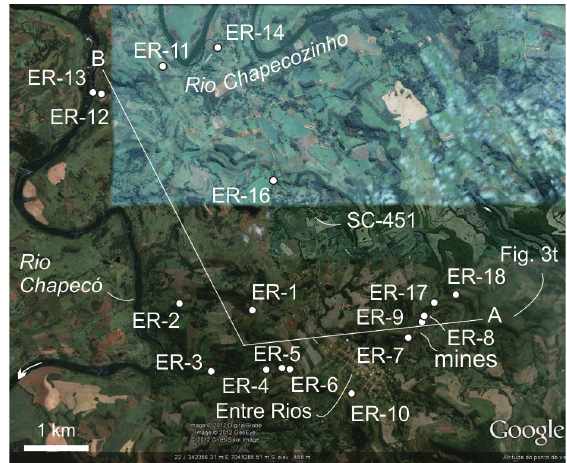
Figure 2 - Satellite image of the Entre Rios mining district. Location of geological section (AB) and analyzed samples